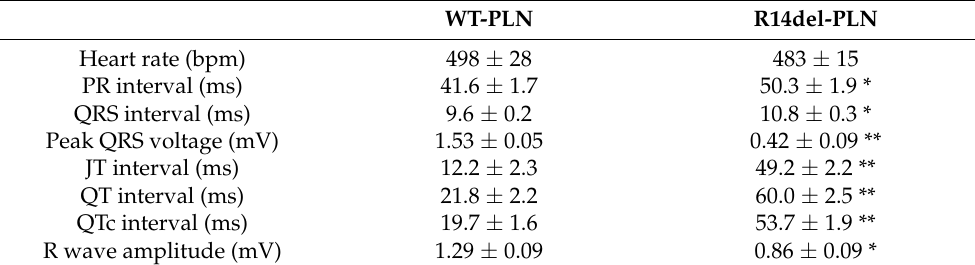
Table 1. Cardiac electrocardiographic assessment in WT-PLN and R14del-PLN mice under in vivo stress